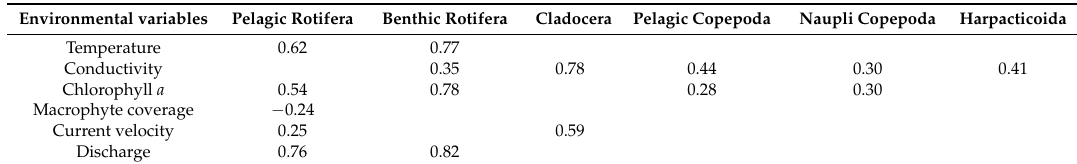
Table 8. Spearman significant correlations with Holm’s correction between zooplankton abundance and environmental variables in the sites of the Corgo river ( p <